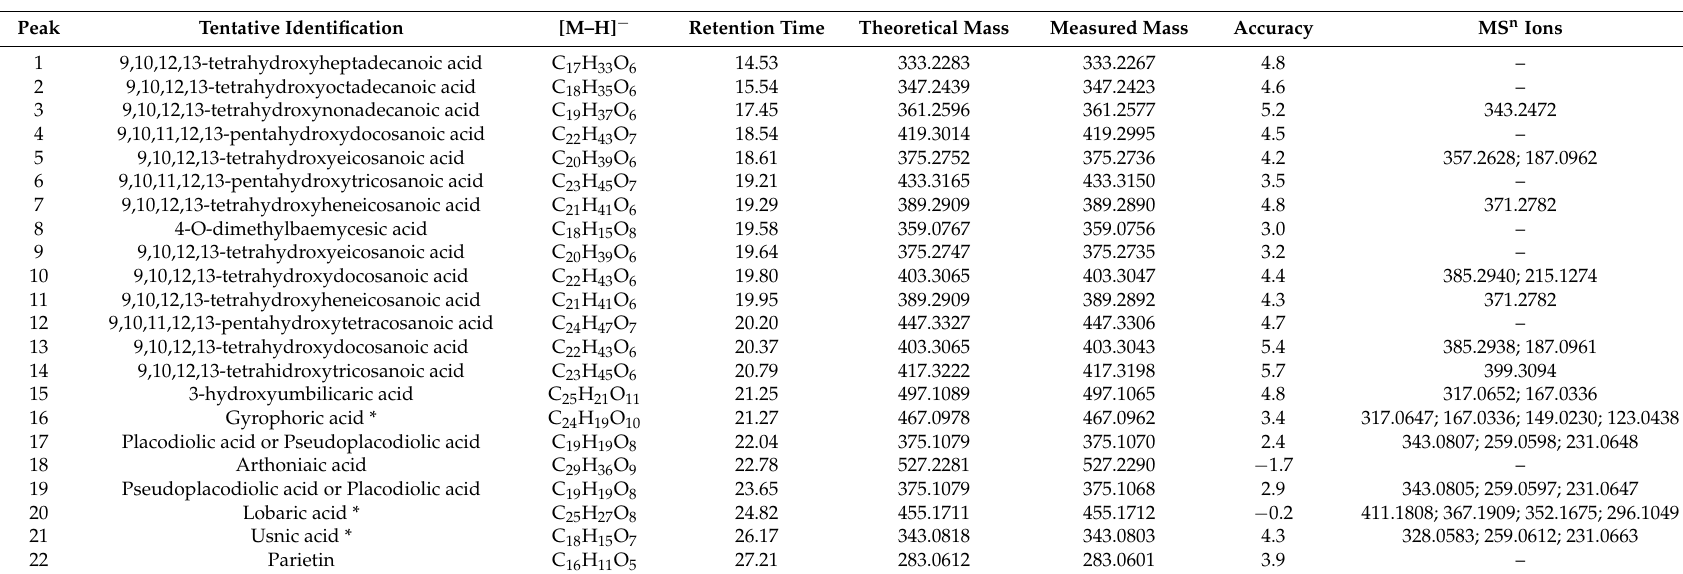
Table 1. Identification of metabolites in Antarctic lichen R. terebrata by UHPLC-Q/Orbitrap/ESI/MS/MS. * Identified by spiking experiments with an authentic compound; retention time (min); theoretical and measured mass ( m / z ); accuracy (ppm).